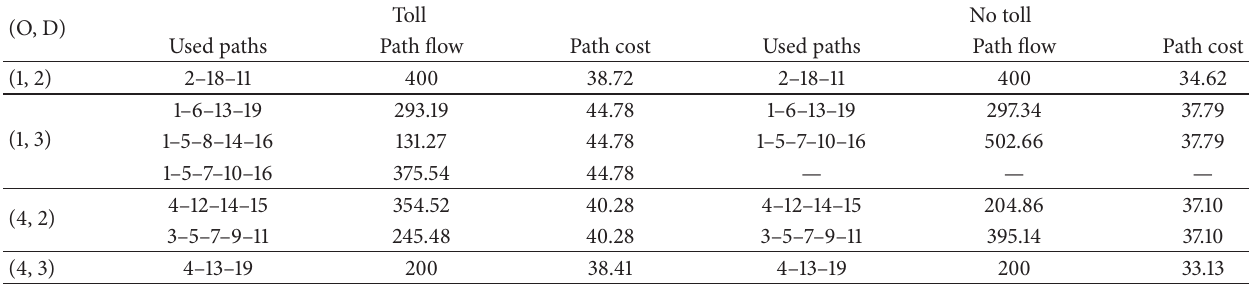
Table 4: Corresponding path flow and path cost (min,